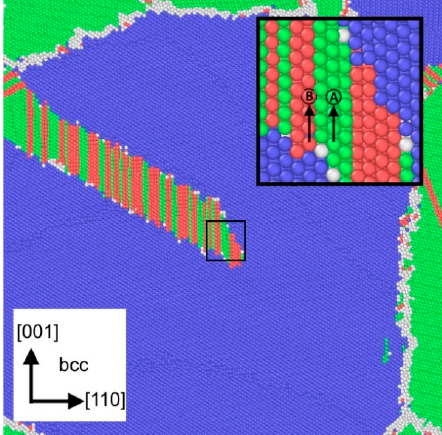
Figure 16. Cross-section of a lamella of the large grain by the bcc (110) plane at the strain 4.20%. Atoms with bcc, fcc, hcp, and uncertain nearest neighbor symmetry are shown in blue, green, red, and light gray, respectively.